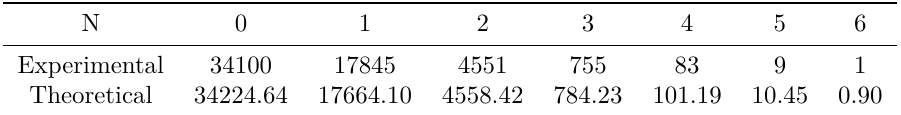
Table 10: Experimental and theoretical distributions of N( a, b ), number of pairs for differential ( a, b ) = ( 0x00002e , 0x220020 ) for 14 × 2 12 randomly chosen key samples. The experimental line contains the histogram of the number of keys for which the differential ( a, b ) has N pairs and the theoretical line the expected number of keys in the case of a Poisson distribution with λ = 2 23 EDP = 0 .